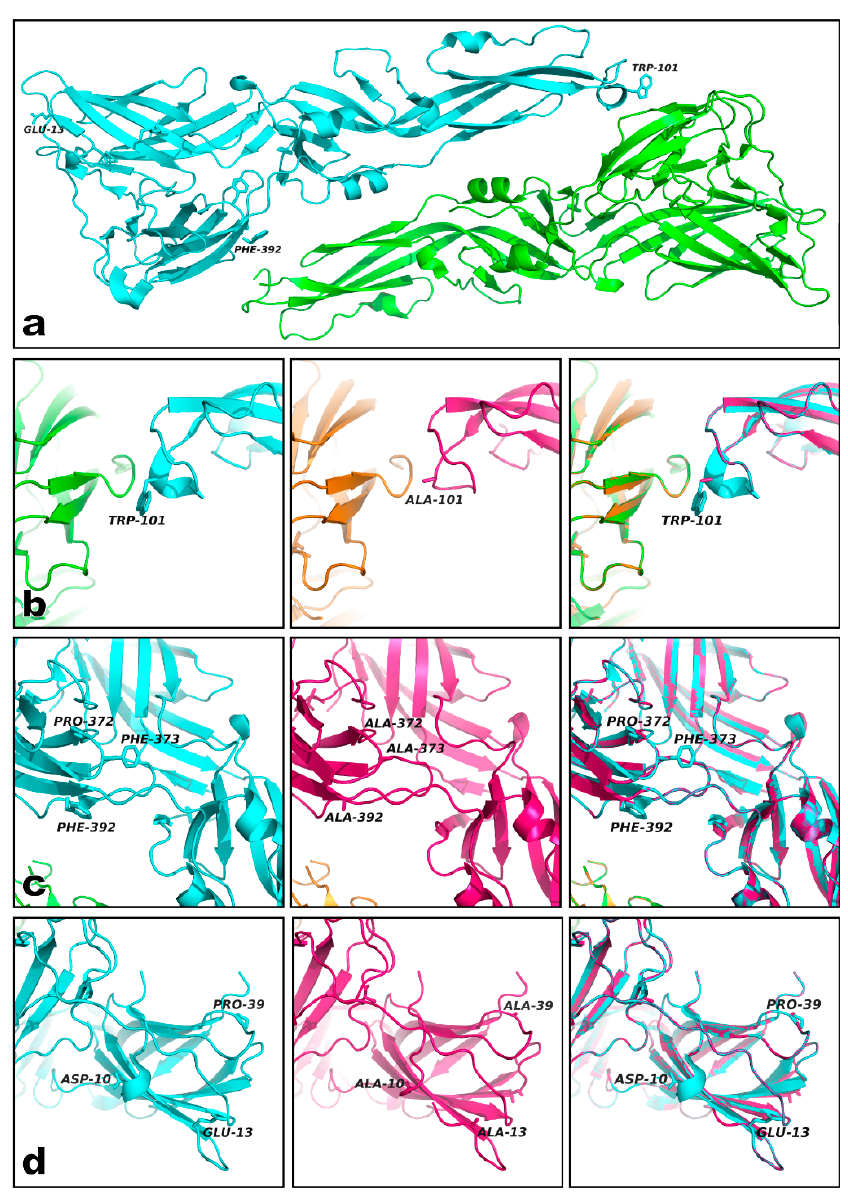
Figure 2. Alanine-substituted epitopes clustered in three regions of the DENV E protein. Alanine-substituted epitopes clustered in three separate regions at the tips of Domain I (Glu13 in a ), II (fusion loop around Trp-101 in a ), and III (Phe-392 in a ). Examples of the alteration of solvent-accessible surfaces induced by the alanine substitutions are shown in panels ( b – d ). The introduction of alanine residues modified the solvent-accessible surface of the cross-reacting epitopes by either changing the orientation of the amino-acid side chain (cyan Trp-101 vs. pink Ala-101 in b ) or the plane of rotation of the ß-sheets constituting the domains (cyan vs. pink structures in c ). Some mutations completely disrupted the secondary structure surrounding the epitope (cyan Asp-10 vs. pink Ala-10 in d ). The predicted overall 3D structures of the synthetic E proteins were not dramatically different from their corresponding parental wild-type proteins.